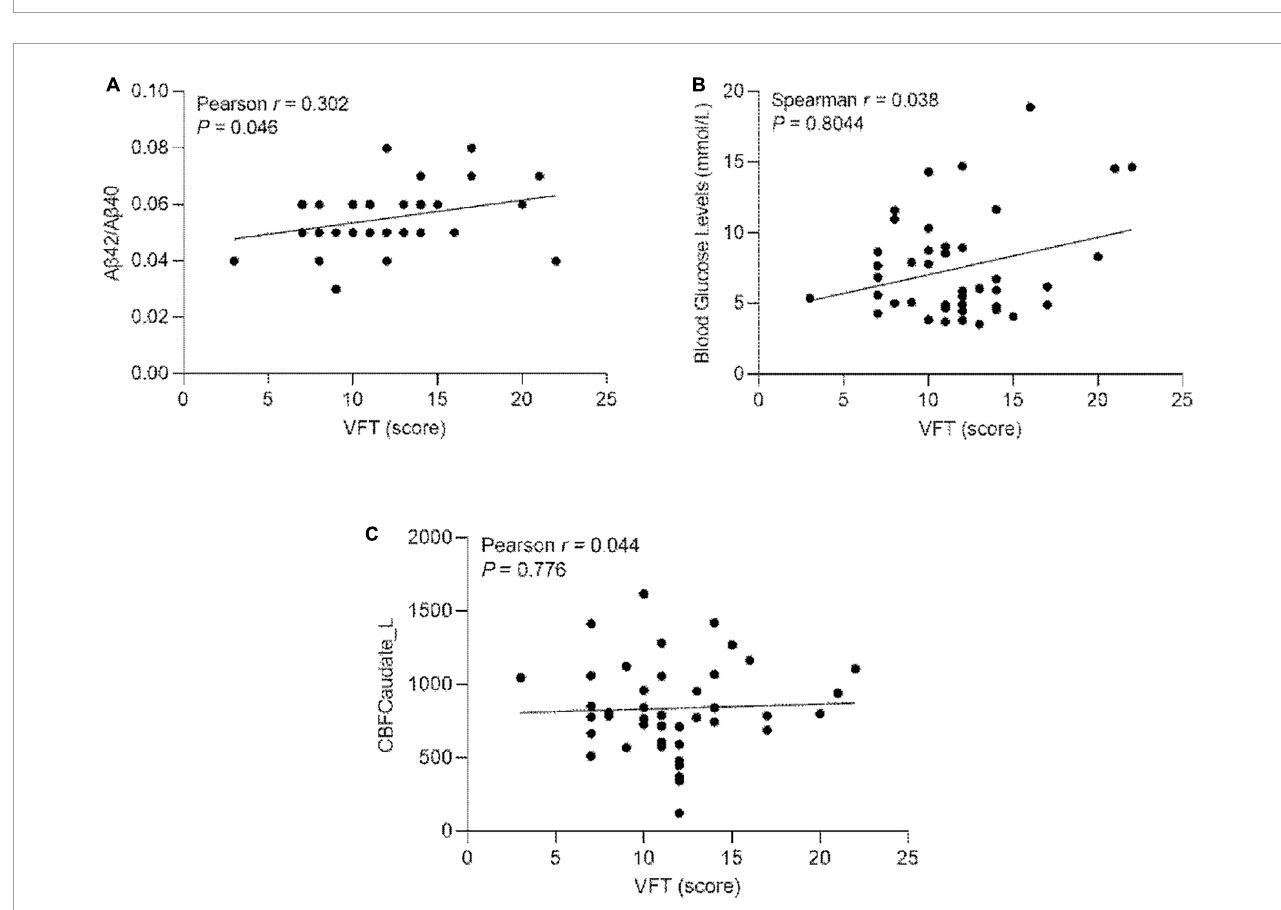
FIGURE5 (A) Pearson’s correlation of the A β 42/A β 40 ratio and the VFT scores in ESRD ( n = 44); (B) Pearson’s correlation of blood glucose levels and VFT scores in ESRD ( n = 44). (C) Pearson’s correlation of the CBF values of left caudate nucleus and the VFT scores in ESRD ( n = 44). Caudate_L, left Caudate; CBF, cerebral blood flow; VFT, verbal fluency